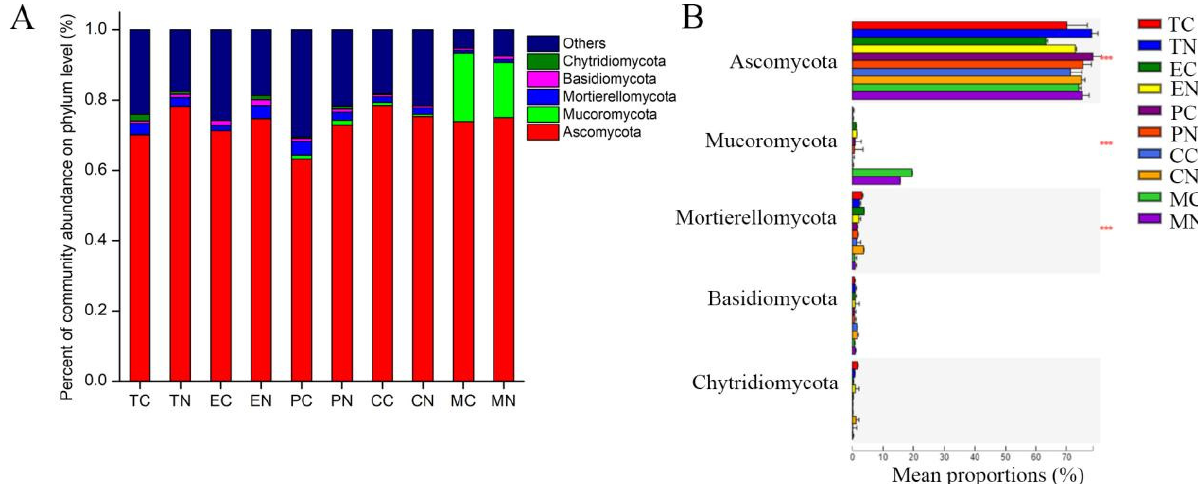
Figure 5. Analysis of compositions of fungal communities from CK and NCD-2 treatments in different crops. ( A ) Percentage of community abundance at phylum level for each crop; ( B ) Significant analysis of community abundance at the phylum level. *** means significantly at p <0.001 level. NCD-2 represents treatment with B. subtilis NCD-2, CK represents treatment with blank control. TC, tomato-CK; TN, tomato-NCD-2; EC, eggplant-CK; EN, eggplant-NCD-2; PC, pepper-CK; PN, pepper-NCD-2; CC, cotton-CK; CN, cotton-NCD-2; MC, maize-CK; MN, maize-NCD-2.